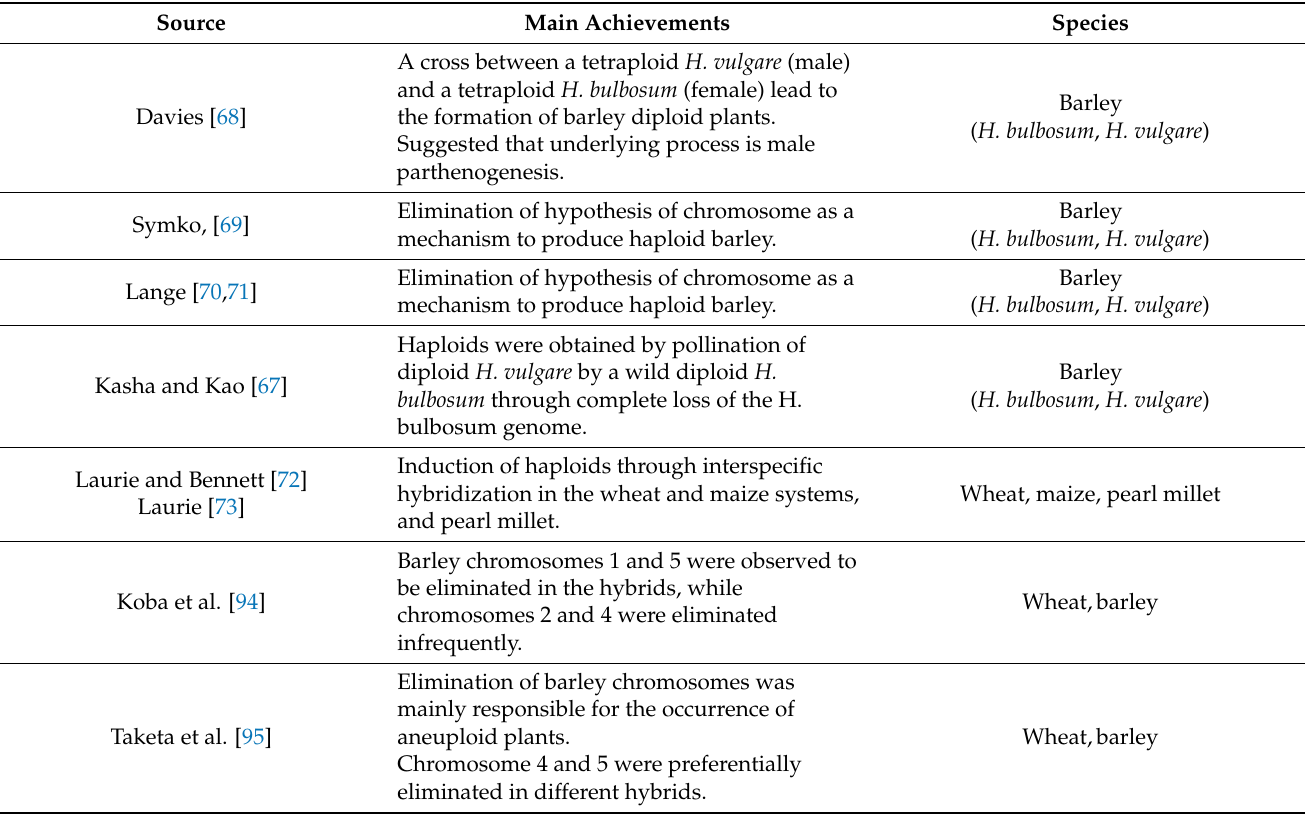
Table 1. Main achievements in haploid induction through interspecific